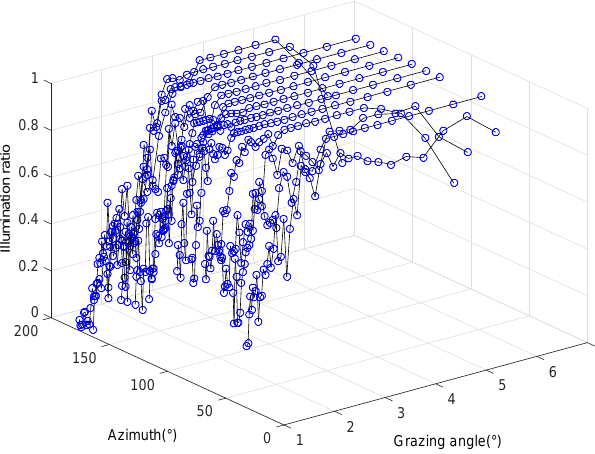
Figure 10. The three-dimensional illumination